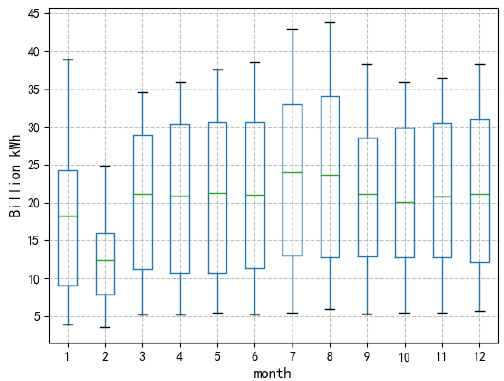
Figure 5. Box–line diagram of the load.